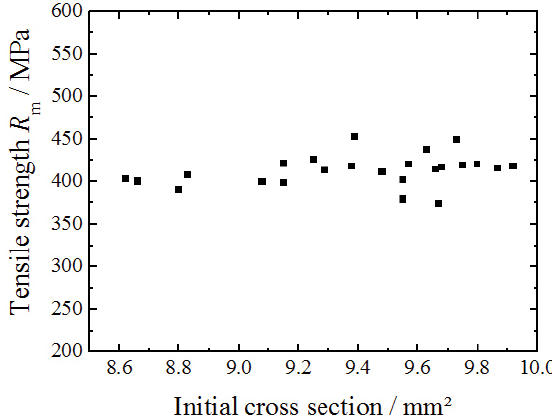
Figure 9. Tensile strengths as a function of initial sample cross sec - tions of cold rolled Cu tapes shows the accuracy of the